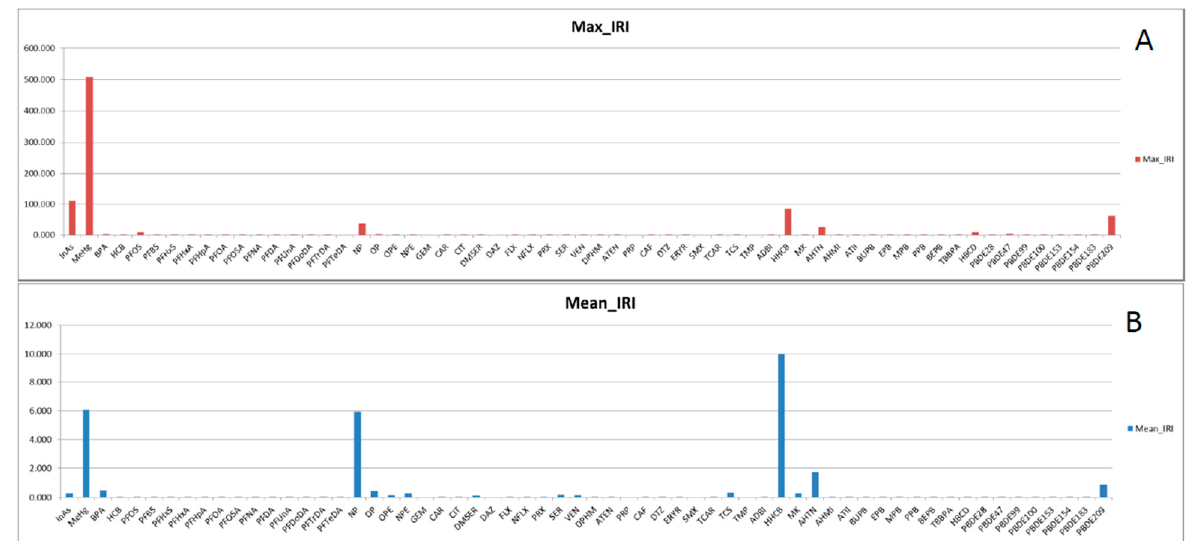
Figure 2. Integrated risk index of ( A ) max (99 percentile) and ( B ) mean (50 percentile) of integrated risk index score.